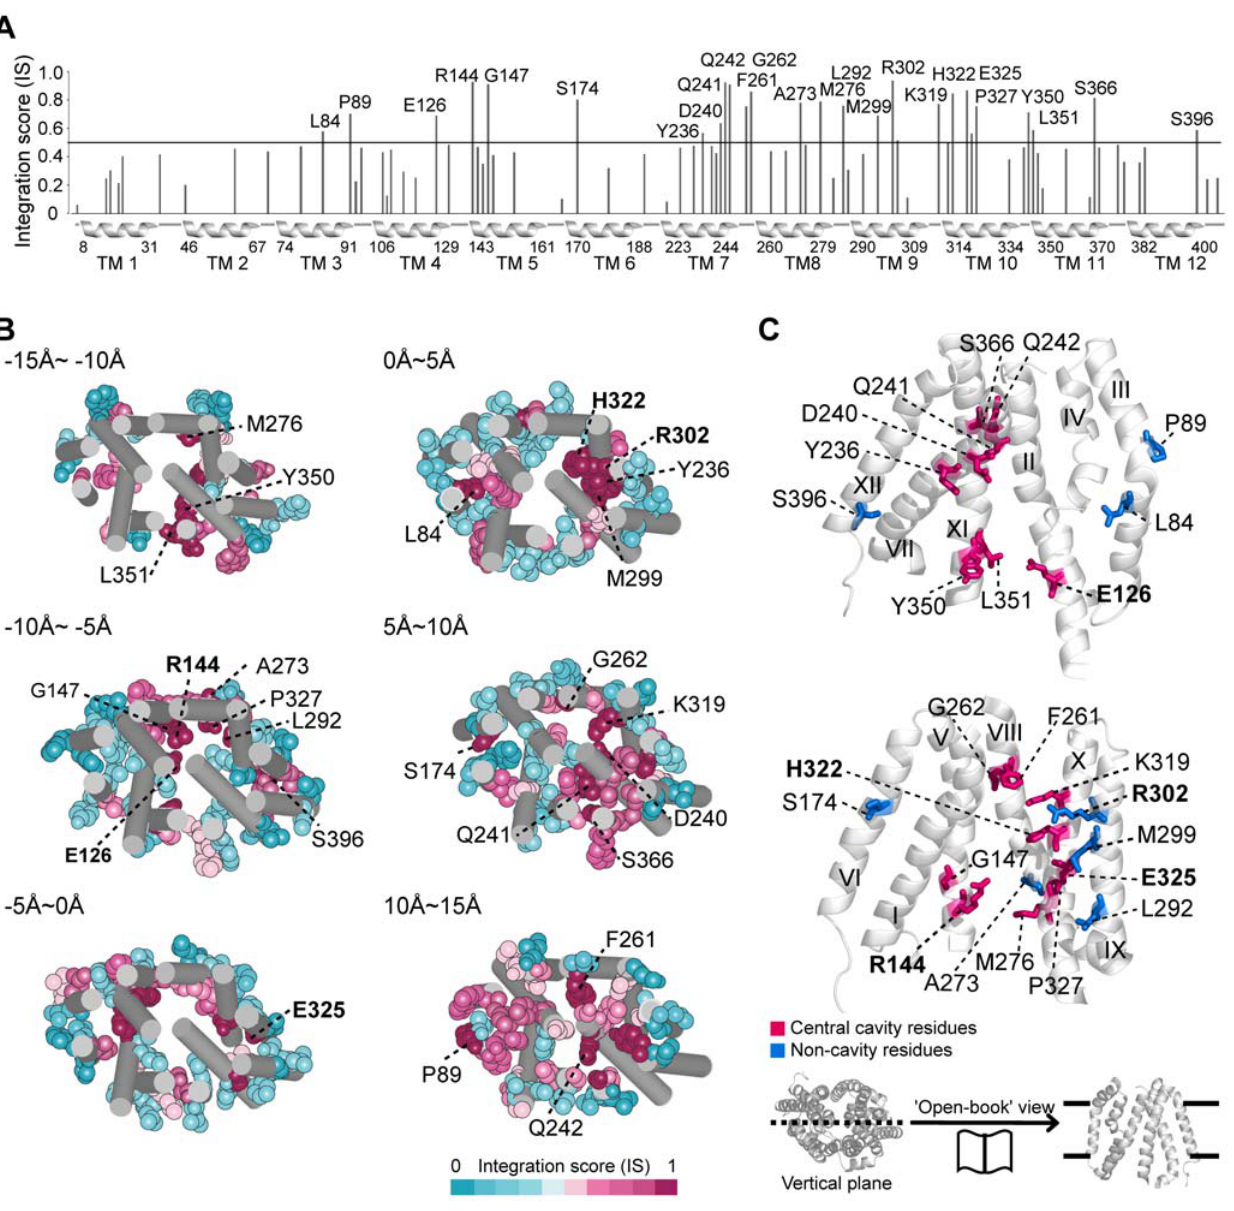
Figure 3. High-IS residues of LacY. (A) IS pattern of LacY. Black line corresponds to the 90 th percentile of IS. Transmembrane regions are indicated as helices below the x-axis with boundary residue numbers; 25 detected residues are labeled with residue numbers. (B) Serial sections of LacY structure from cytoplasm ( 2 15 A˚) to periplasm (15 A˚). The detected residues are shown as vdW spheres with residue numbers; 5 irreplaceable residues are shown in bold. (C) ‘Open book’ view of the detected residues in LacY. Central cavity and non-cavity residues are shown in red and blue sticks, respectively; five irreplaceable residues are indicated as bold characters. Transmembrane helix numbers are shown in roman numerals.